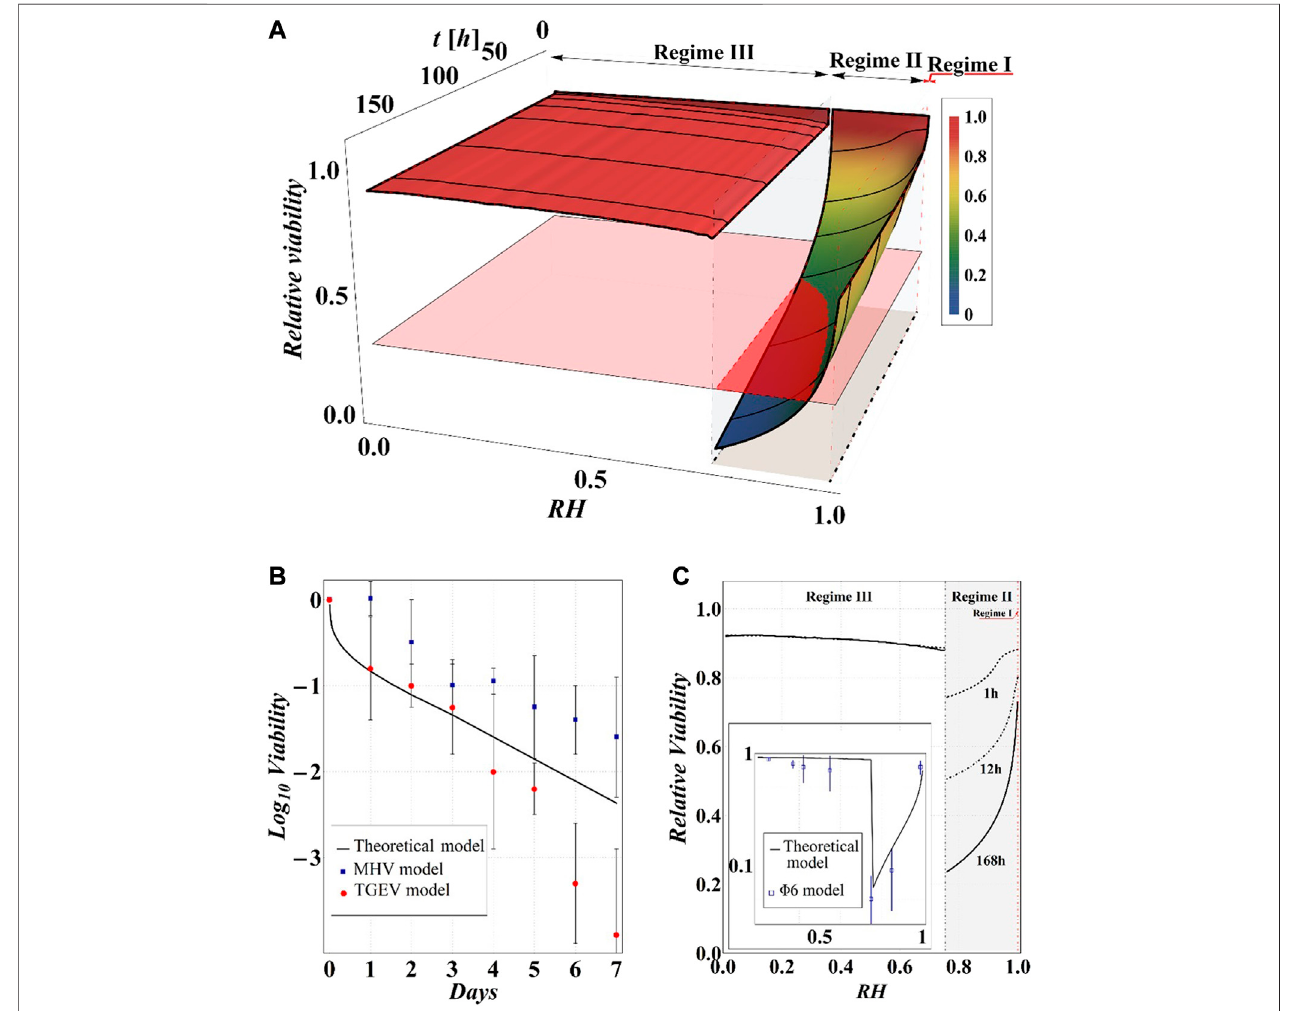
FIGURE11 | (A) Resultsof model calculationsof the evaporation process of asessile drop of aqueous solution in terms ofrelativeviability of thevirusas afunction of the time and the RH, for a starting volume of the drop equal to 1 μ L and θ EQ (cid:2) π / 18; (B) Time evolution of the logarithm of the relative viability at an RH (cid:2) 80%, comparedtosurvivalmeasurementsoftwosurrogatesofSARS-CoV,thetransmissiblegastroenteritisvirus(TGEV)andmousehepatitisvirus(MHV).Thedatahavebeen re-adapted from Casanova et al. (Casanova et al., 2010). (C) Evolution of relative viability as a function of the RH. In the inset, the comparison of the theoretical outcomes (continuous line) with experimental data for the Phi6 model virus (Prussin et al., 2018; Lin and Marr, 2020) shows the same trend and highlights the so-called “ U-shaped ”